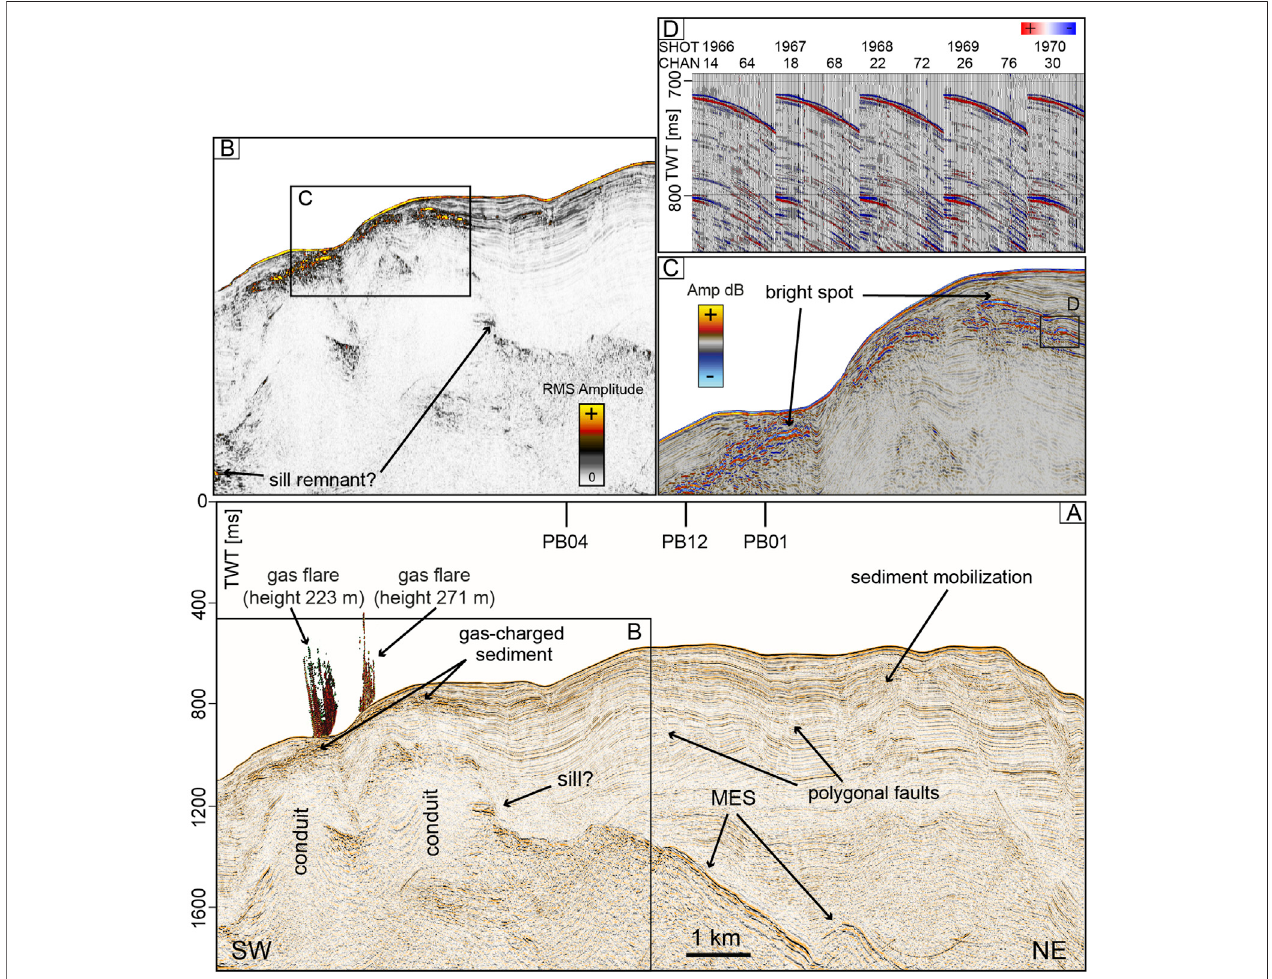
FIGURE 6 | (A) Seismic re fl ection pro fi le PB03 showing diapirism and conduits below two gas fl ares in the water column. (B) RMS Iterative amplitude extracted fromthepro fi leportionoutlinedin (A) andshowingbrightspots,andpossibleremnantsofamagmaticsill. (C) Insetoutlinedin (B) wherebrightspotsareindicated. (D) 5 consecutive shot records along pro fi le PB03 at trace 2,739 and 800 ms where a bright spot is present. A large ormsby band pass fi lter (10 – 20/500 – 1,000 Hz) was applied to remove the background noise. Location in Figure 2A .